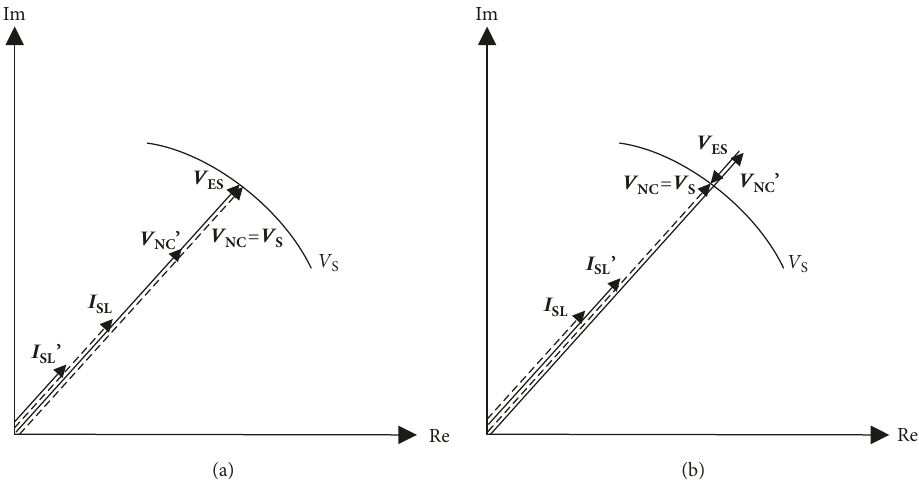
Figure 4: The vector diagram when ES is applied to restrain the demand side power fluctuation while noncritical load is resistive. (a) Resistive mode. (b) Negative resistive mode.